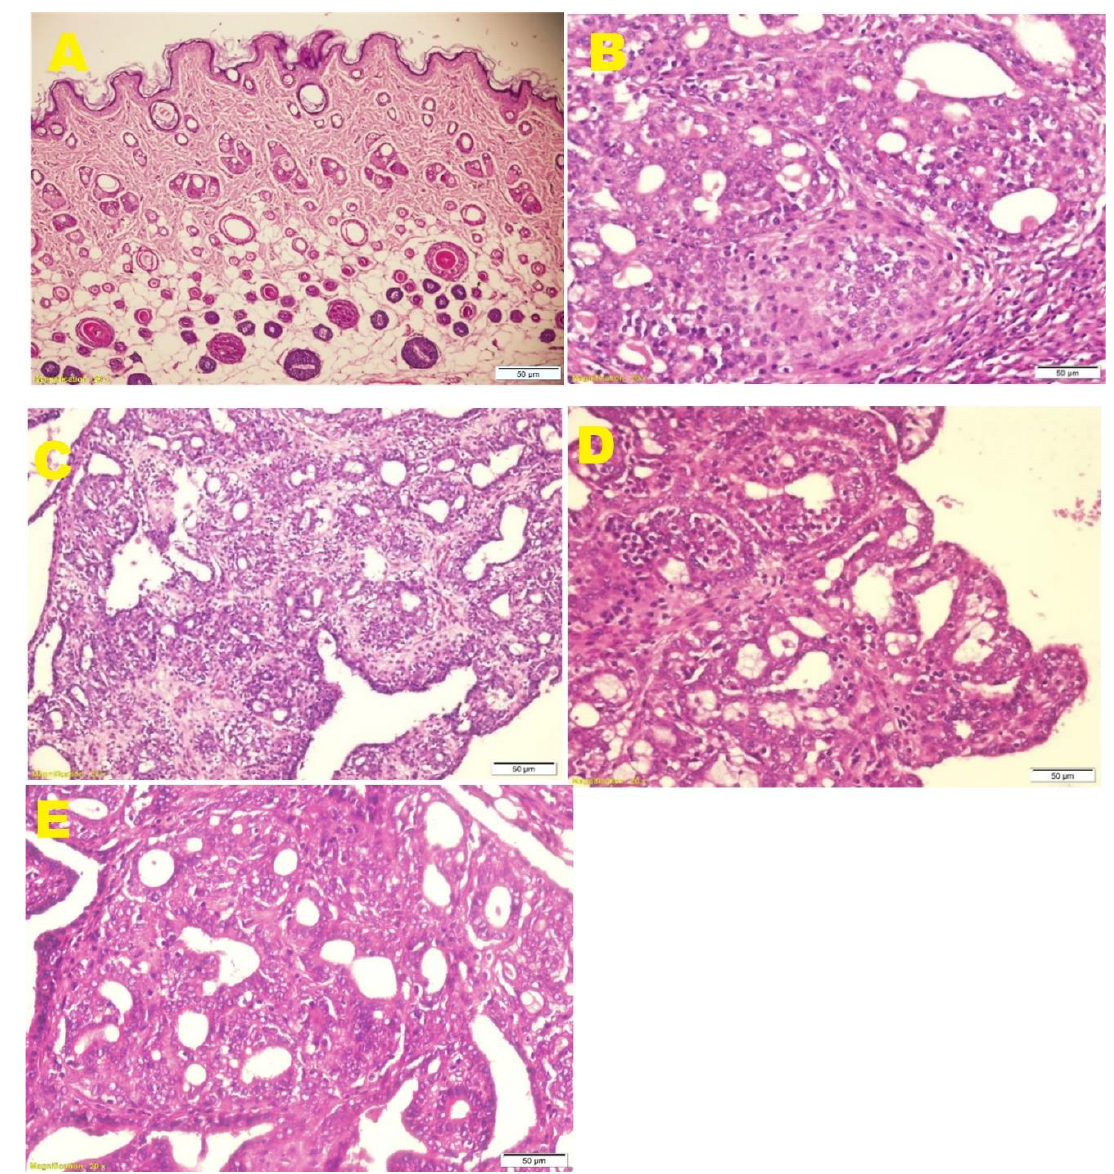
Figure 2. Photomicrographs of mammary cancer in rats induced by DMBA and treated with EOAm. ( A ) Control group, ( B ) DMBA, ( C ) DMBA + EOAm 50 mg/kg, ( D ) DMBA + EOAm 100 mg/kg, ( E ) DMBA + EOAm 200 mg/kg. 2.4. Biochemical Markers in Animals Treated with the Essential Oil from A. muricata